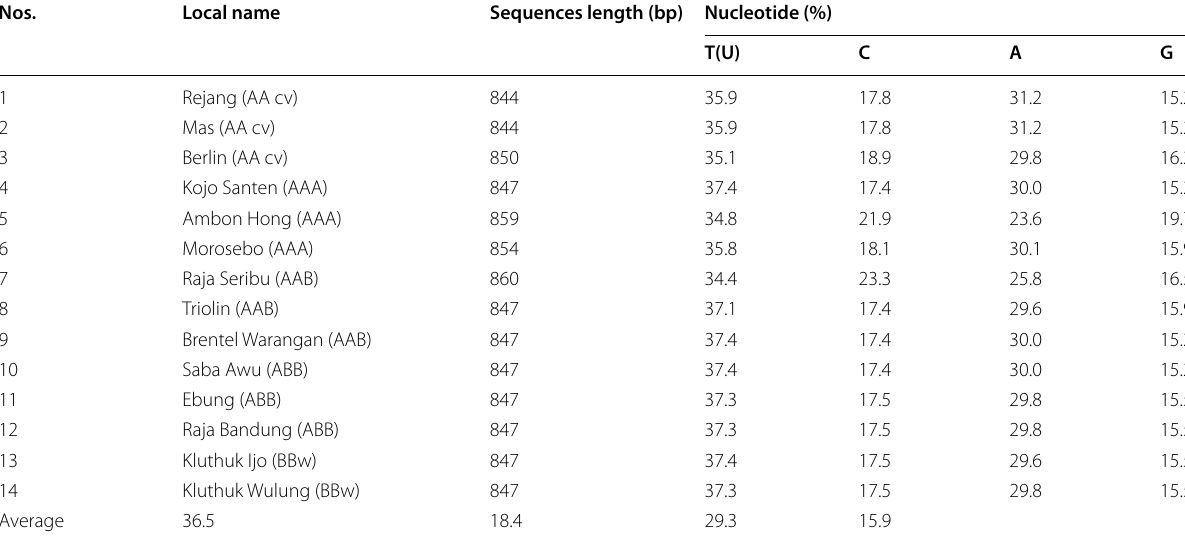
G Guanin, A Adenin, C Cytosin, T Thymin, U Uracil